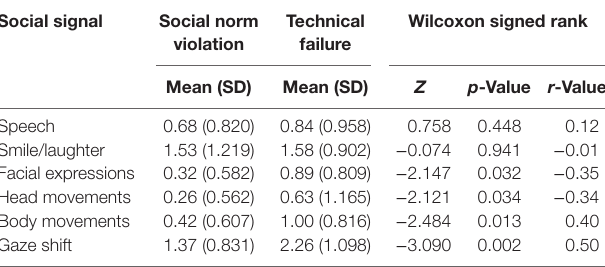
Table 8 | social signals shown during social norm violations and technical failures. social